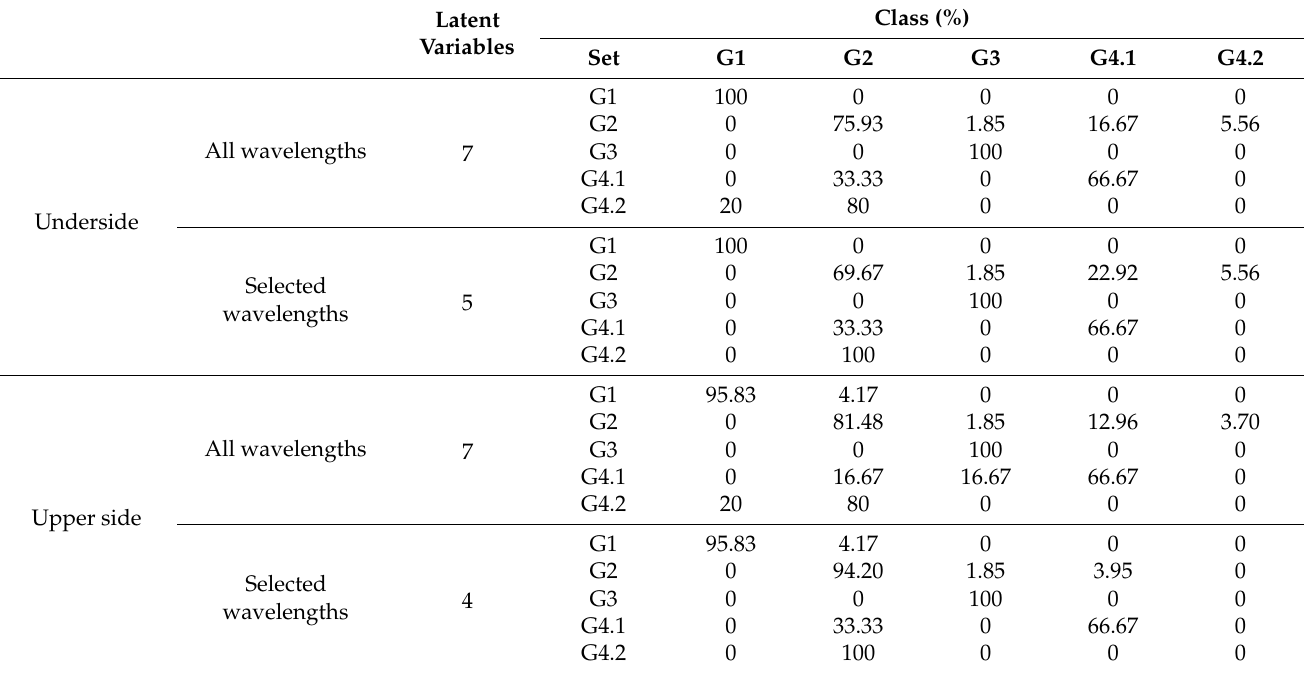
Table 6. Damage classification according to the presence of different types of damage of the validation set by PLS-DA using all and selected wavelengths on each side of the